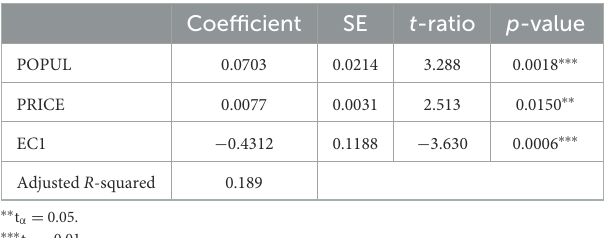
TABLE 8A VECM, VAR(1)—Equation 1:d_IMPORT.